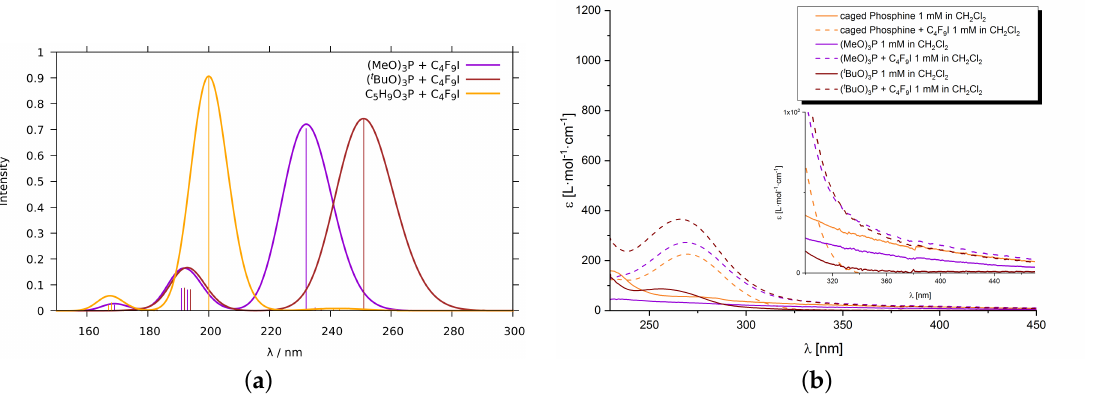
Figure 11. ( a ) Calculated and ( b ) measured absorption spectra of the three phosphite–IC 4 F 9 adducts. In addition, experimental absorption spectra of the pure phosphites in DCM solution are